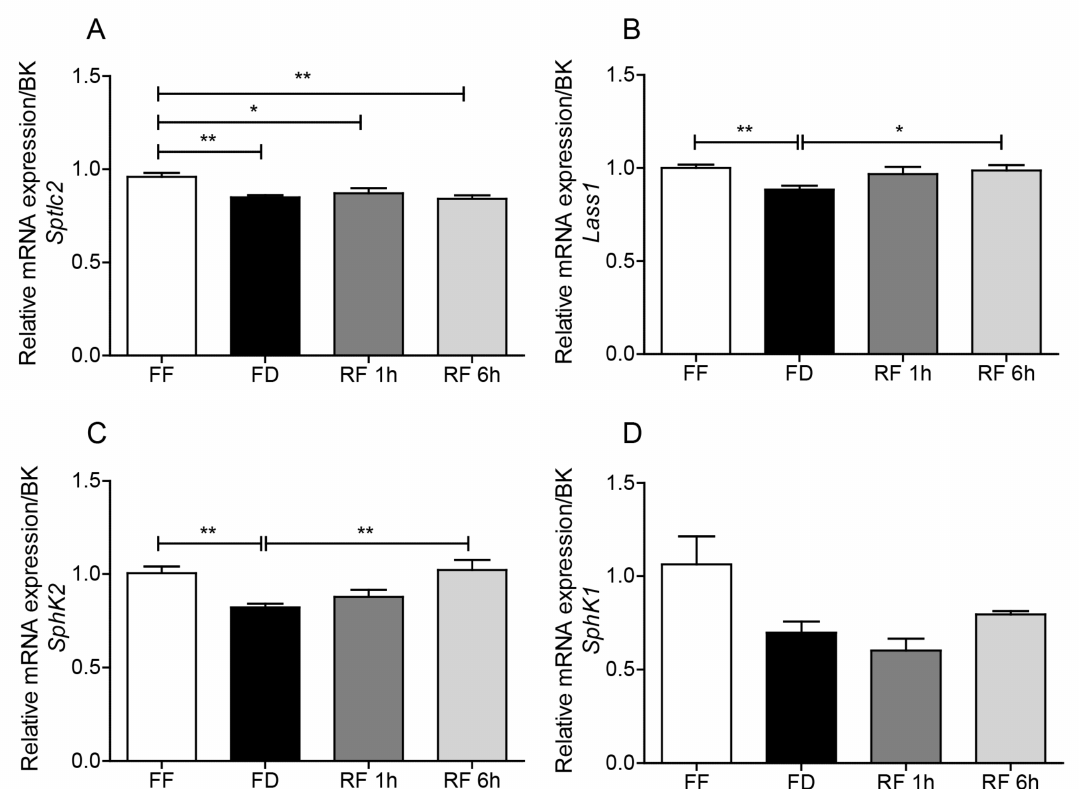
Figure 4. E ff ects of feeding status on transcription of ( A ) serine palmitoyltransferase long chain base subunit 2 ( Sptlc 2), ( B ) ceramide synthase 1 ( Lass1 ), ( C ) sphingosine / sphinganine kinase 2 ( SphK2 ), ( D ) sphingosine / sphinganine kinase 1 ( SphK1 ). Free feeding (FF), 12 h food deprivation (FD), 1